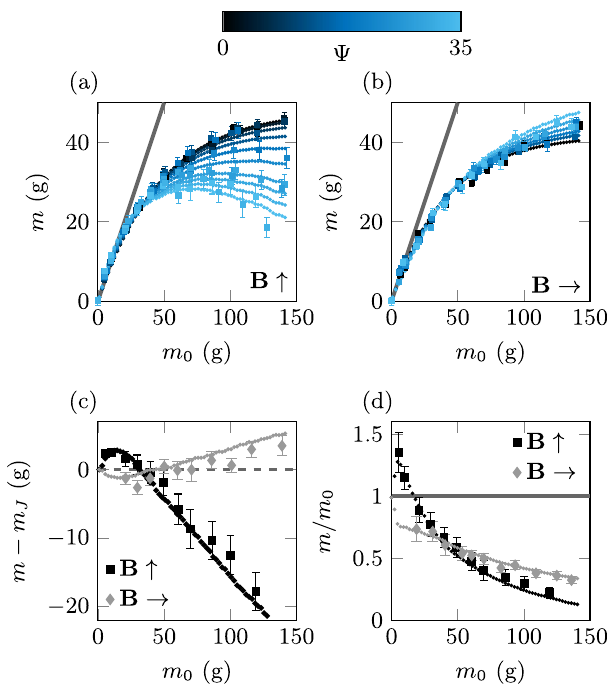
Fig. 2 Apparent mass measurements and predictions. a , b Mass measurement of the bead packing for different fi eld intensity, characterized by Ψ , and direction. The gray line corresponds to the hydrostatic limit. For a fi eld amplitude Ψ = 35, c gives the difference between the mass measurement and Janssen prediction m J ; while d displays the mass measurement renormalized by the true mass of the column m 0 , the gray line corresponds to the hydrostatic limit, m = m 0 . Our theoretical model (points reported on the various panels) reproduces quantitatively our experimental measurements (square